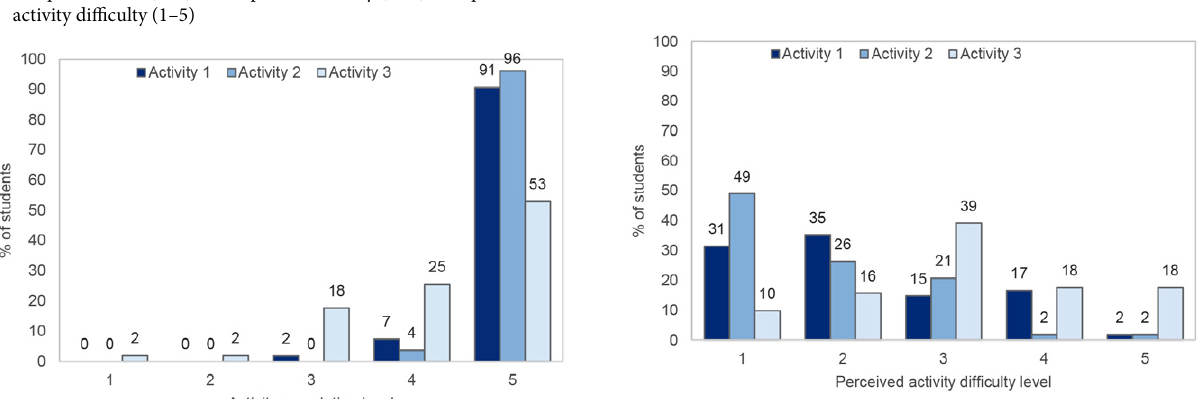
Figure 5: Distribution of time spent on activity by activity